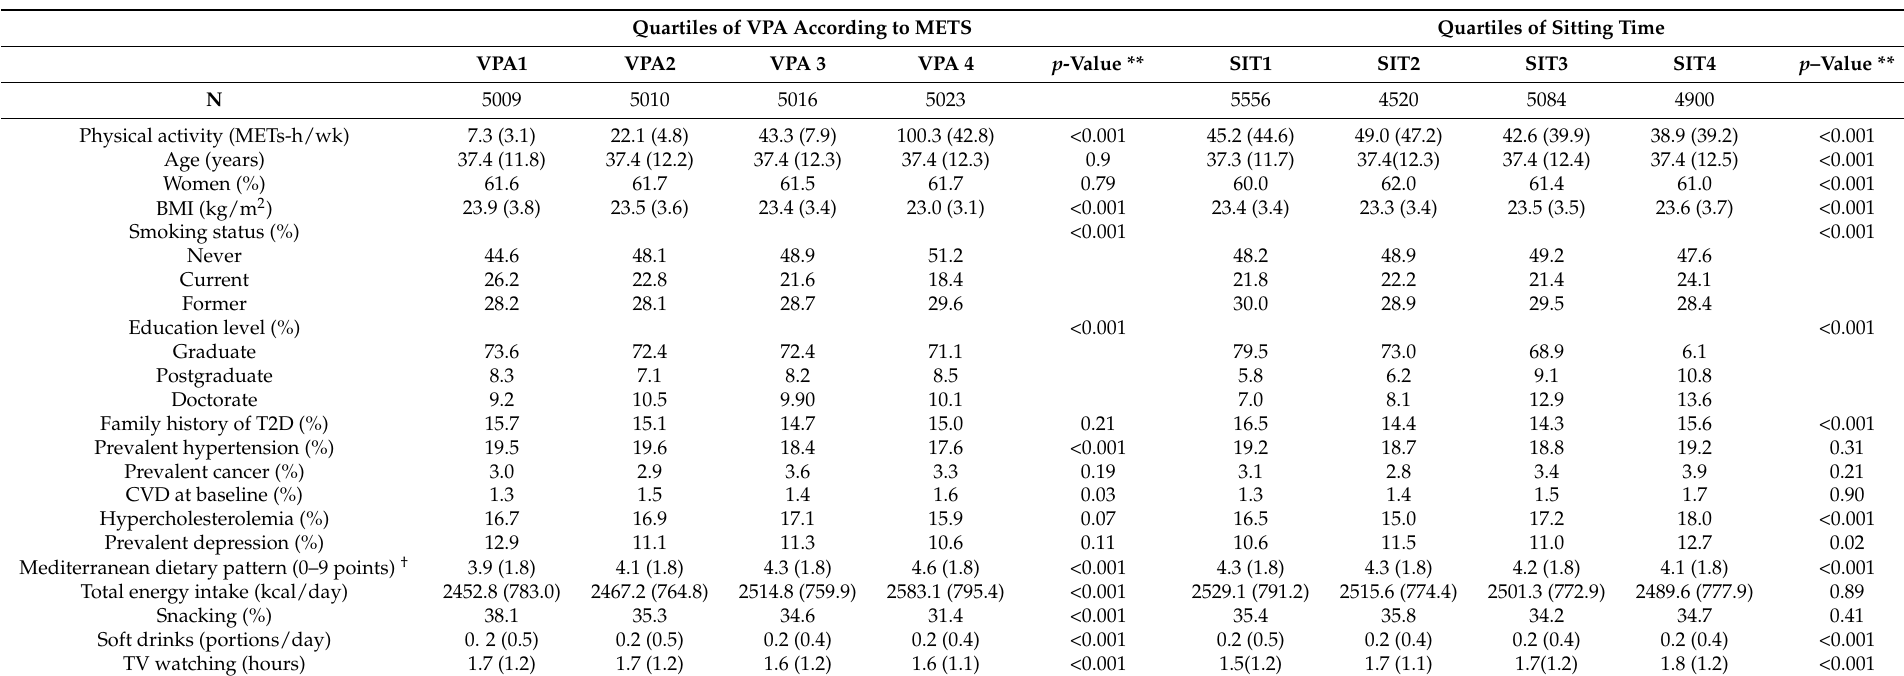
Table 1. Age- and sex-adjusted * characteristics of the SUN participants according to quartiles of sitting time and